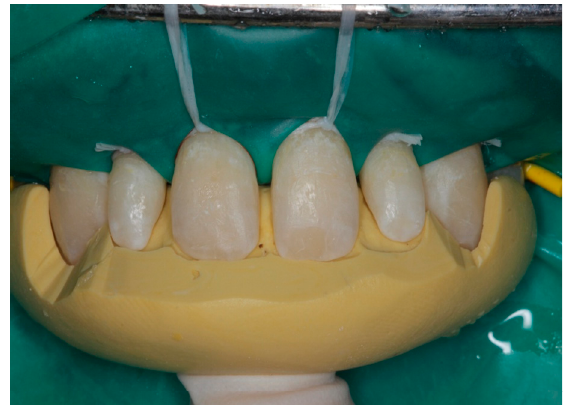
Figure 9. Case 3 clinical procedure.